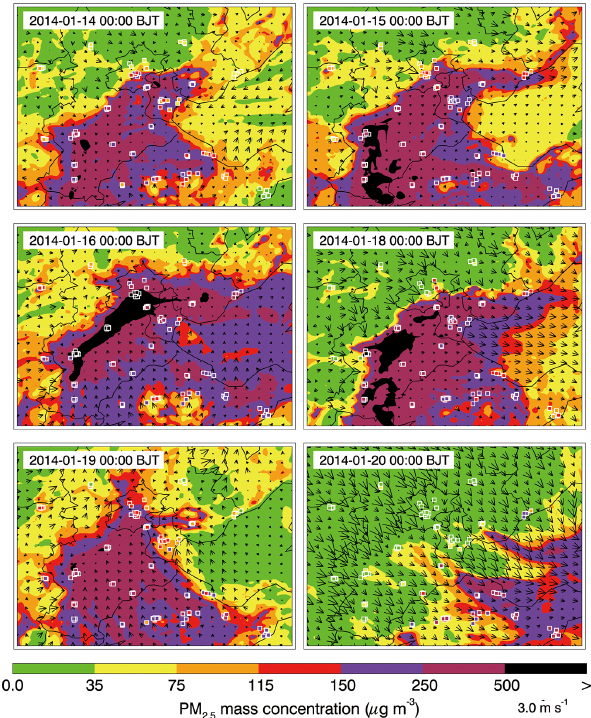
Figure 7. Pattern comparison of simulated vs. observed near- surface PM 2 . 5 at 00:00BJT during the 6 selected days in GZB from 16 to 27 December 2013. Colored circles are PM 2 . 5 observations, color contours are PM 2 . 5 simulations in the E-case, black arrows indicate simulated surface winds in the E-case.